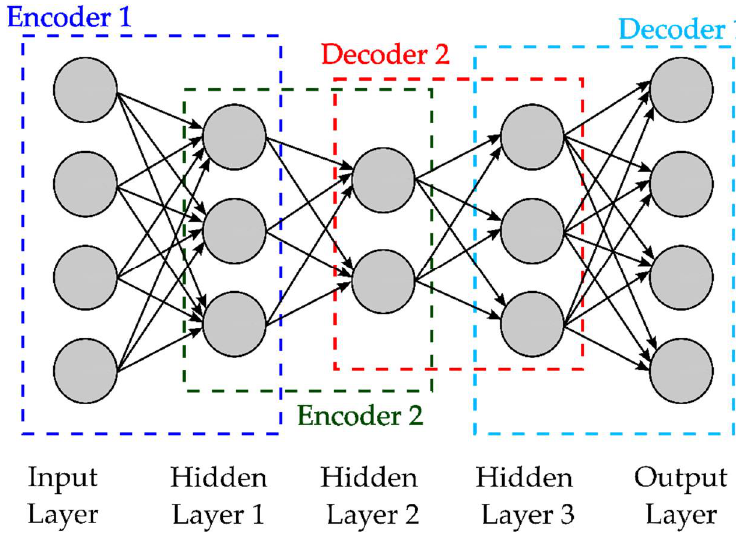
Figure 1. Stacked autoencoder composed of two autoencoders.